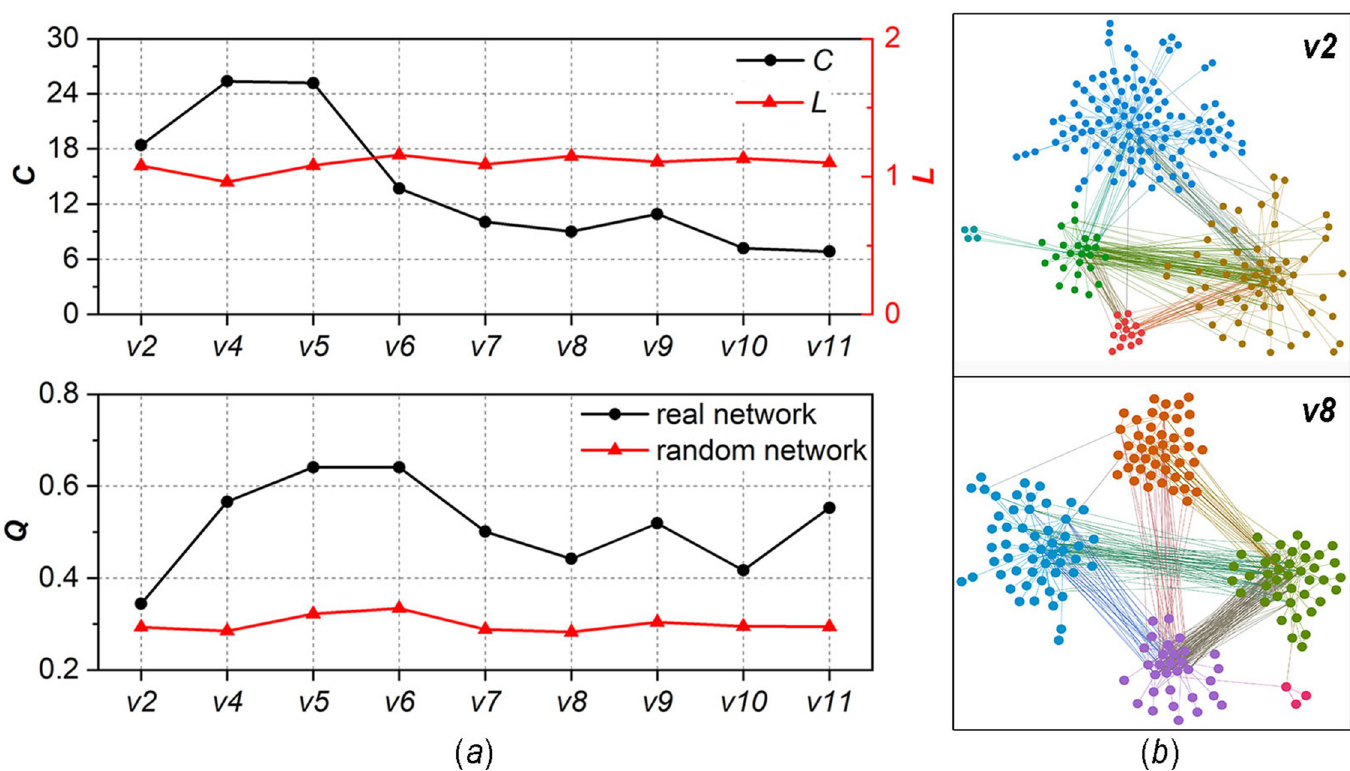
Fig 3. Characteristics of structural evolution of the giant component, (a) evolution of C , L , and Q , (b) topology of sample networks.